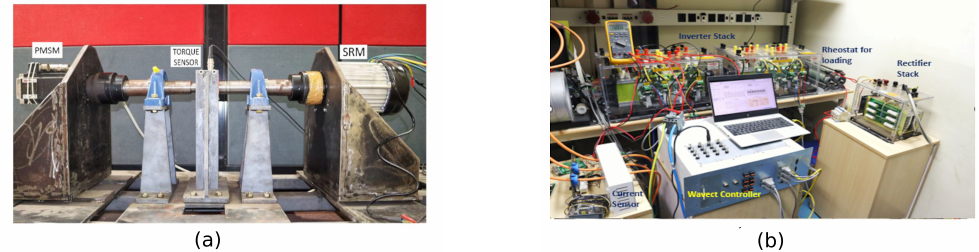
Figure 11. ( a ) Experimental setup of static measurements and ( b ) controller test setup of the pro- posed